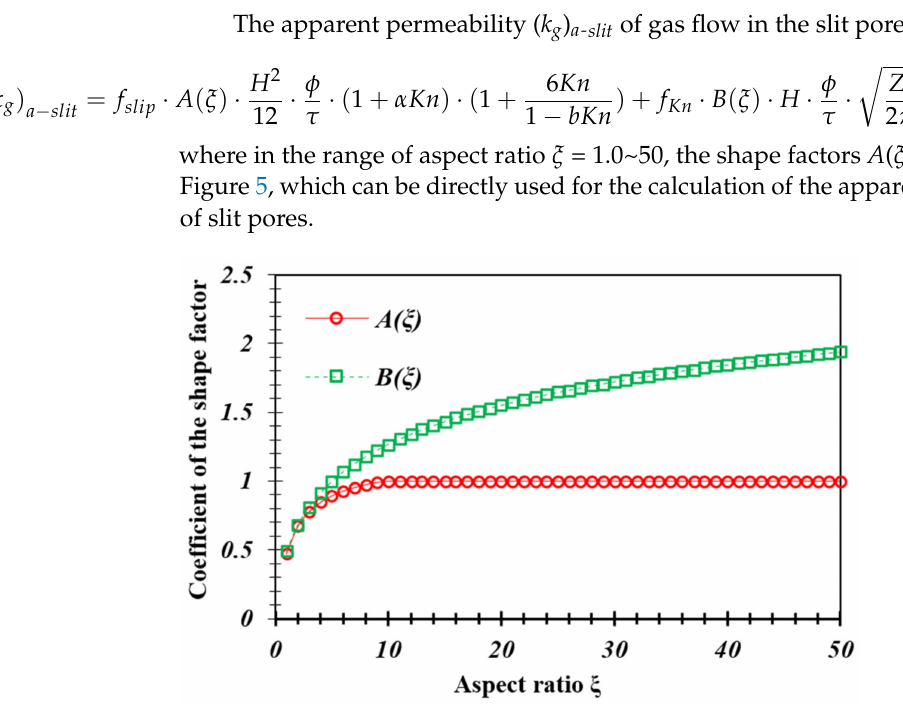
Figure 5. The shape factors A ( ξ ) and B ( ξ ) with different aspect